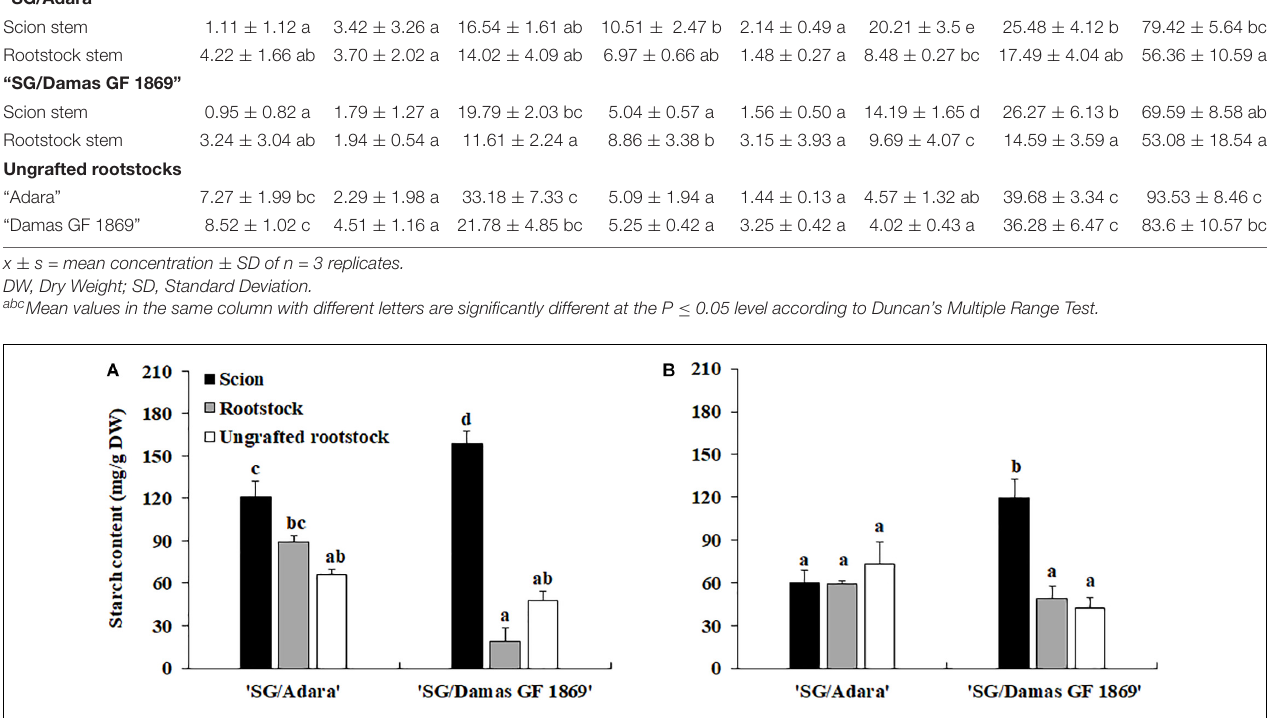
FIGURE 2 | Starch content (mg/g DW) in the scion and rootstock of the compatible (“SG/Adara”) and incompatible (“SG/Damas GF 1869”) graft-combinations, and ungrafted rootstocks [ (A) October 2017; (B) June 2018] 3 years after grafting. Vertical bars represent the mean ± Standard Error (SE) ( n = 3 replicates). For each graph, abc Mean values are significantly different at the P ≤ 0.05 level according to Duncan’s Multiple Range